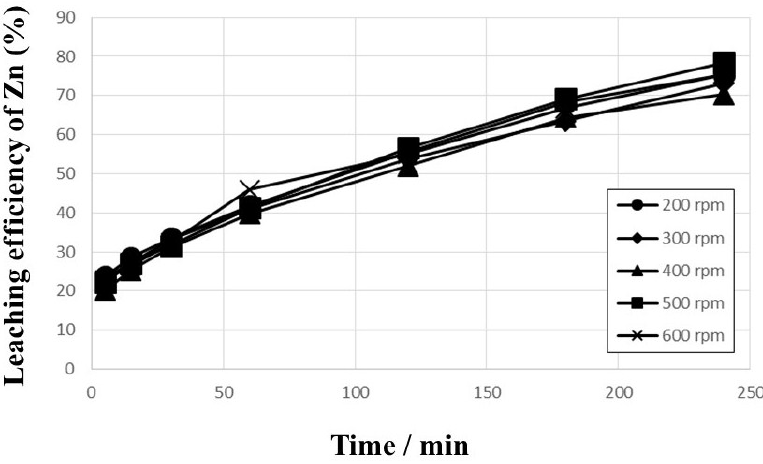
Figure 2. The effects of agitation speed on the leaching efficiency of Zn at 1 kmol·m −3 HCl with 1 kmol·m −3 Fe 3+ , 10% pulp density, and 50